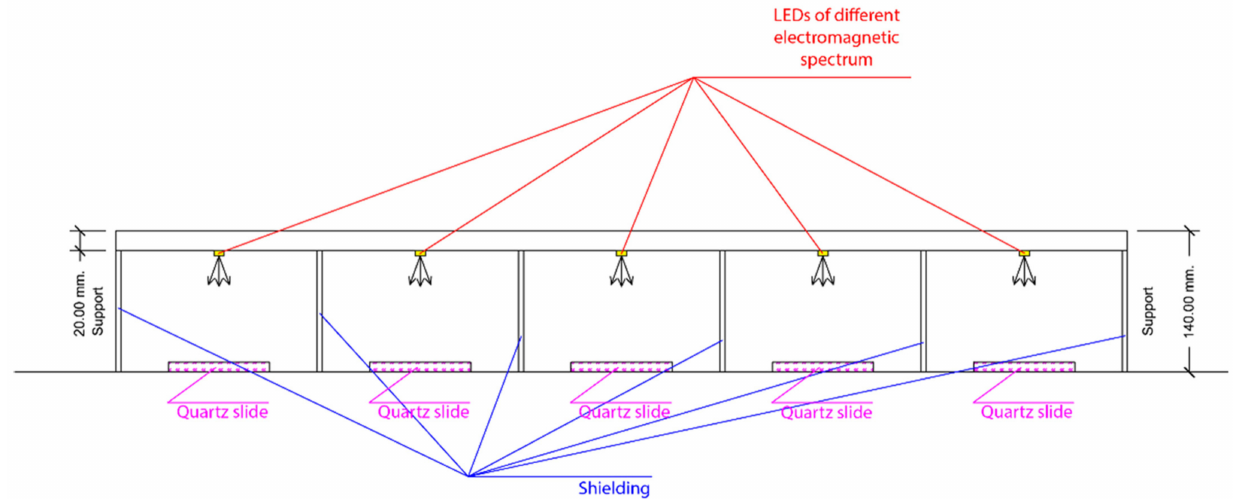
Figure 2. Rainbow exposure system . A dedicated devise was applied to perform, in parallel, simultaneous light treatments under identical conditions, but using LED with different wavelength emissions. The exposure setting ranged from 350 to 630 nm, and temperature was monitored in real time by a thermocouple thermometer. Distance from the light source and the target was constant for all exposure chambers. To avoid evaporation, a quartz cover was only considered for longer exposures when using water